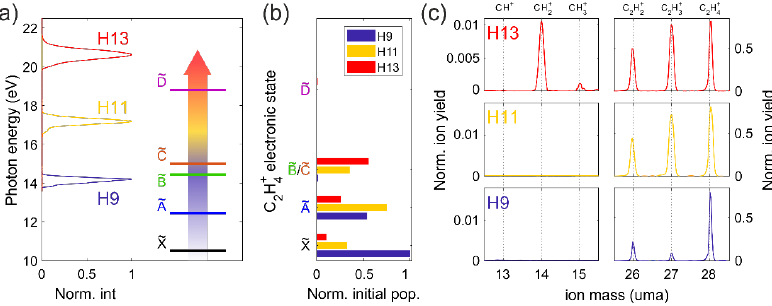
Fig. 1. (a) VUV spectrum of the high-order harmonics used in the experiment together with the first five states of molecular cation [7]. (b) Initial state population calculated with the partial cross-sections taken from [8] and the harmonic spectra in (a). (c) Normalized ion yield of the main charge particles obtained by photo-fragmentation. After selection, the VUV radiation is focused on an ethylene gas target placed in the focal spot of a time-of-flight (TOF) mass spectrometer. Upon absorption of a harmonic photon, the molecule is ionized and left in an excited state. In particular, we used the 9 th , the 11 th and the 13 th harmonic (H9 to H13 in Fig. 1(a)) to selectively populate the first four excited states of C 2 H 4+ : X ̃, Ã , B ̃ and C ̃ (see Fig. 1(b)). H9 enables a very efficient excitation of the X ̃ state, H11 of the A ̃ state, while H13 predominantly excite the B ̃ and C